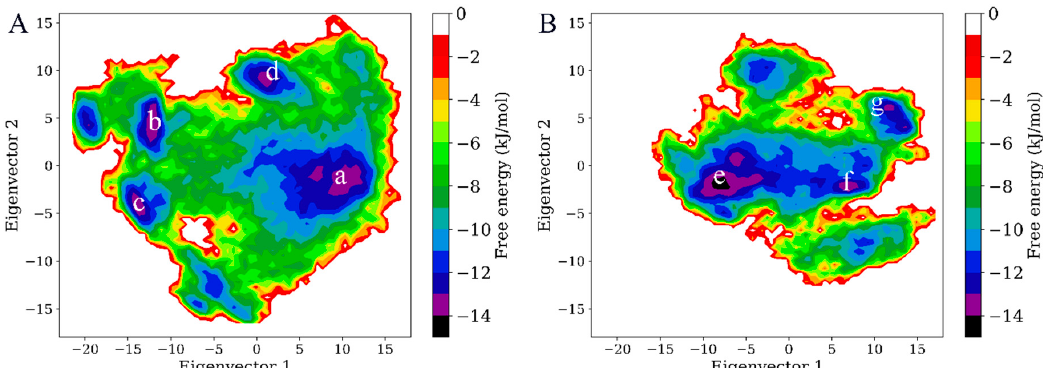
Figure 6. Constructed free energy landscapes (FELs) of the two forms of gp120 using projections of eigenvectors 1 and 2 as the reaction coordinates. ( A ) FEL of the CD4-free gp120. ( B ) FEL of the CD4-complexed gp120. The color bar indicates the relative free energy value in kJ/mol. The basins/minima with free energy level lower than − 13 kJ/mol are labelled “a” to “d” in ( A ) and “e” to “g” in ( B ).